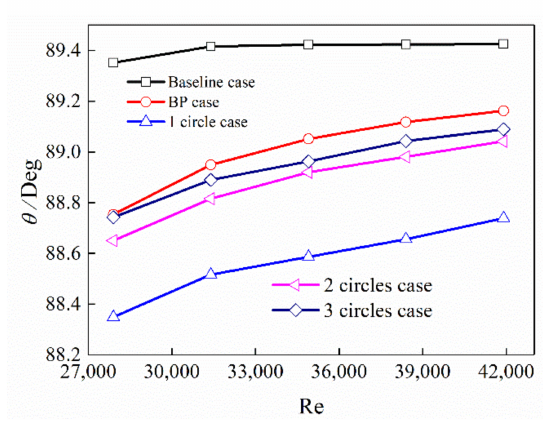
Figure 18. Distributions of synergy angle in some cases.